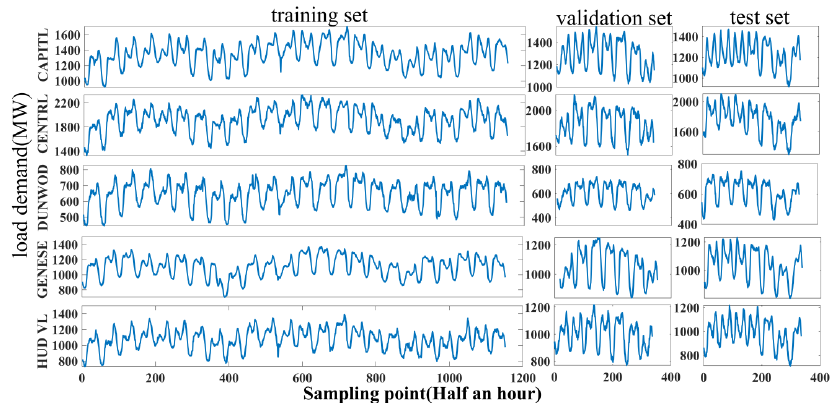
Figure 8. Dataset for